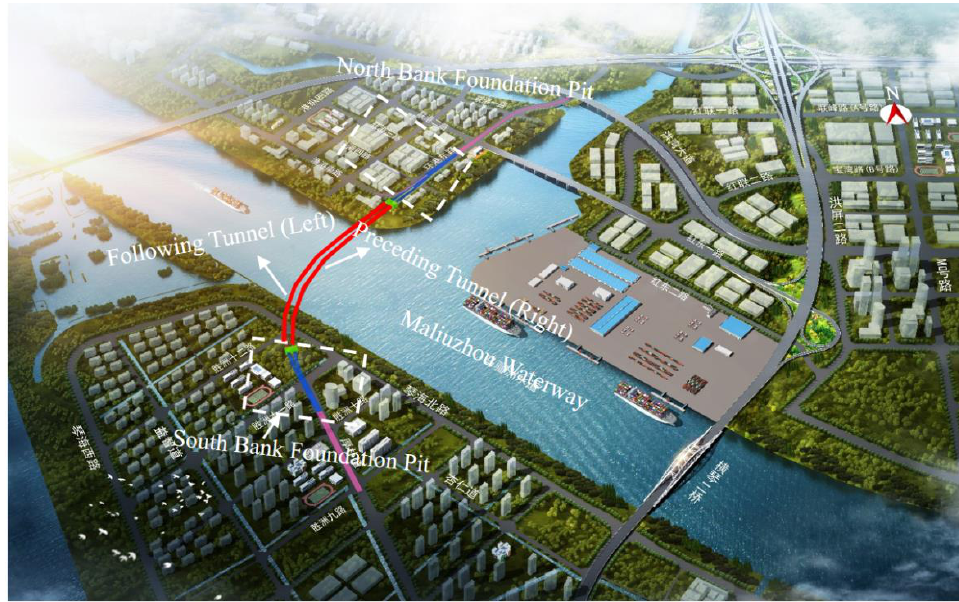
Figure 1. Location of the Mangzhou Tunnel project in Zhuhai, China. Due to the disadvantages of the natural geological conditions, the reinforcement method was implemented in the actual construction process to ensure the stability of the excavation face for the twin tunnels. The influence mechanism of the left tunnel excavation (following excavation) on the right tunnel (preceding excavation) is taken as the main focus of this paper. In particular, the effect of reinforcement strategies will be emphasized and compared. As shown in Figure 2, four different reinforcement strategies were investigated: (a) ring reinforcement of right tunnel (denoted by RR) [26–28]; (b) ring reinforcement of left tunnel (denoted by LR); (c) ring reinforcement of twin tunnels (denoted by TR); (d) cement wall reinforcement between the left and the right tunnels (denoted by CR). The yellow zone in Figure 2 is the reinforcement layer and the symbol t represents the thickness of the reinforcement. Furthermore, to obtain the suitable thickness of reinforcement, six cases, i.e., t = 0 D , 0.05 D , 0.10 D , 0.15 D , 0.20 D , 0.30 D , were studied and compared for each reinforcement strategy.